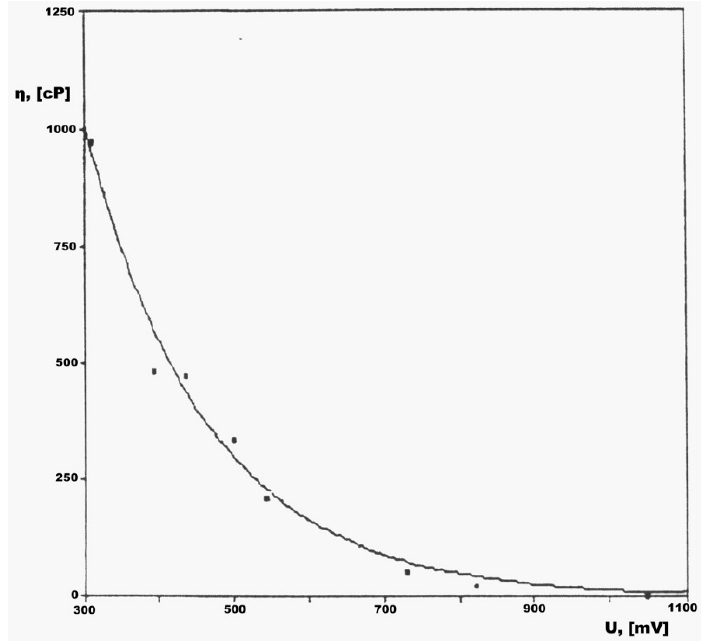
Figure 5. Calibration curve, η = f (U).